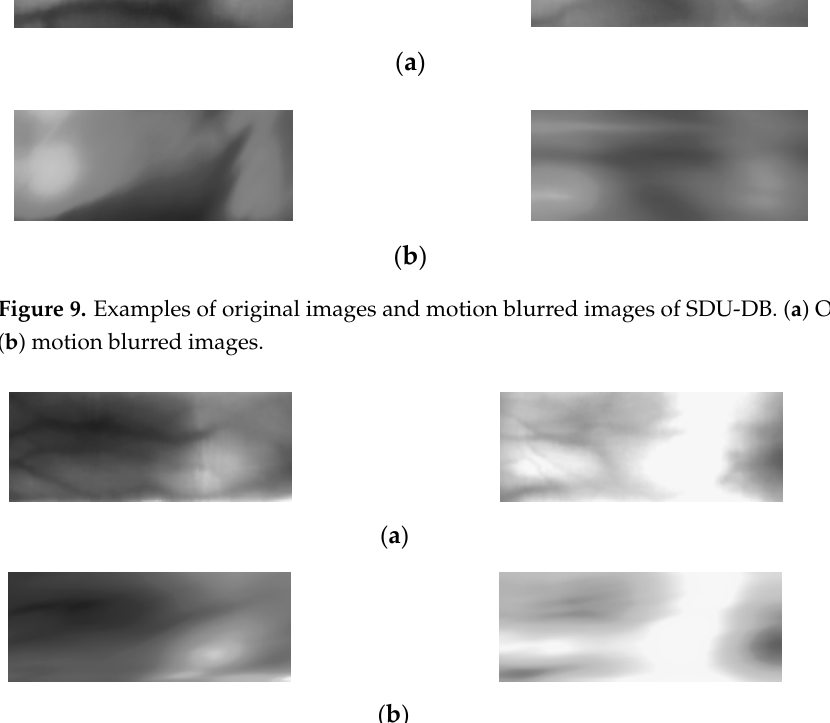
Figure 10. Examples of original images and motion blurred images of PolyU-DB. ( a ) Original images; ( b ) motion blurred images.